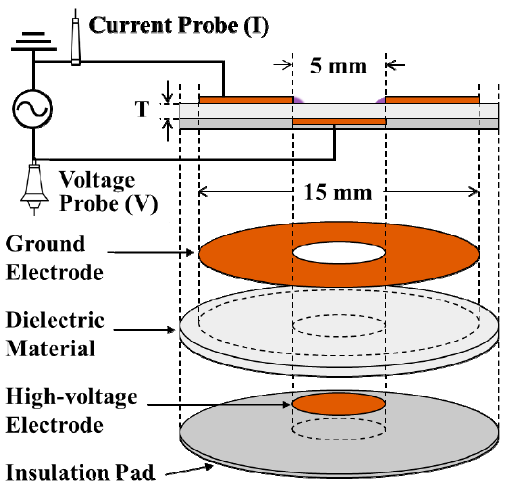
Figure 2. Schematic diagram of the planar-discharge experiments performed in the atmospheric environment with the various dielectric materials listed in Table 1.